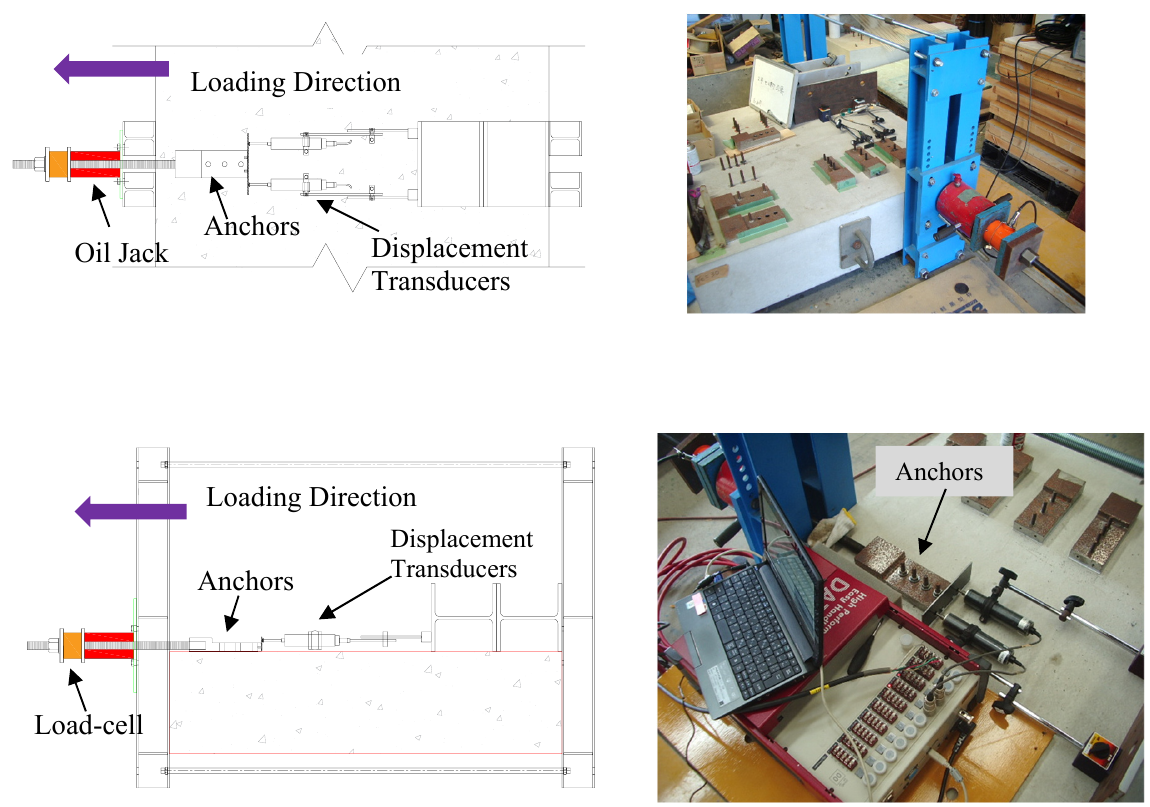
Figure 1. (a) Framing Plan of Loading Apparatus, Loading Apparatus. (b) Elevation of Loading Apparatus, Loading